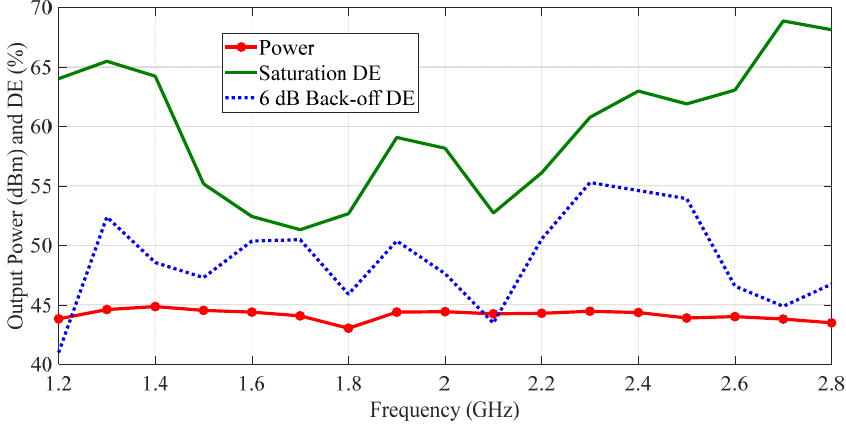
Figure 9. Simulated output power and drain efficiency of the designed DPA versus frequency.